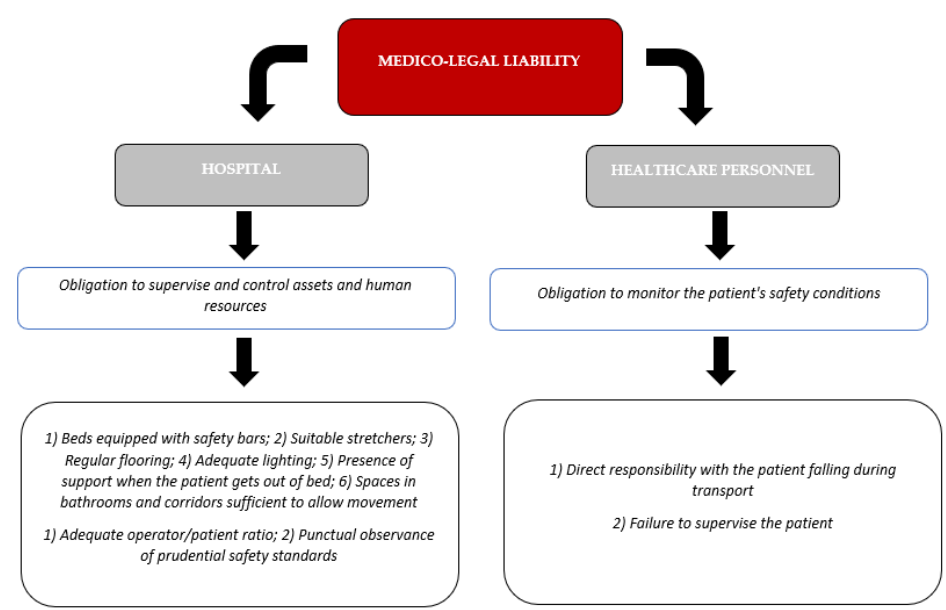
Figure 5. Profiles of liability due to falling in hospital environment.